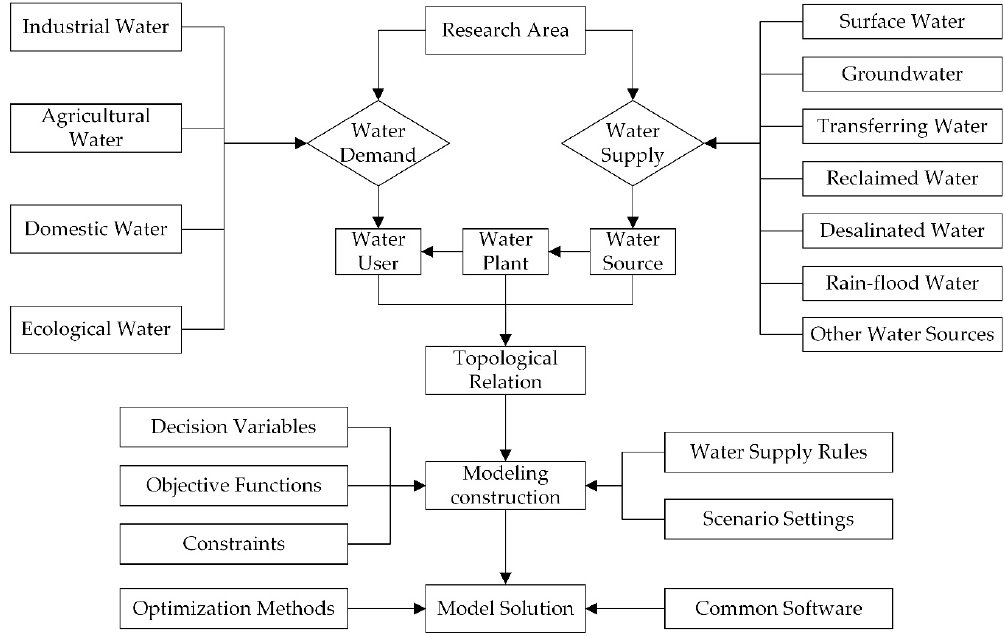
Figure 5. Schematic of interval multi-stage stochastic fuzzy programming (IMSFP) model.